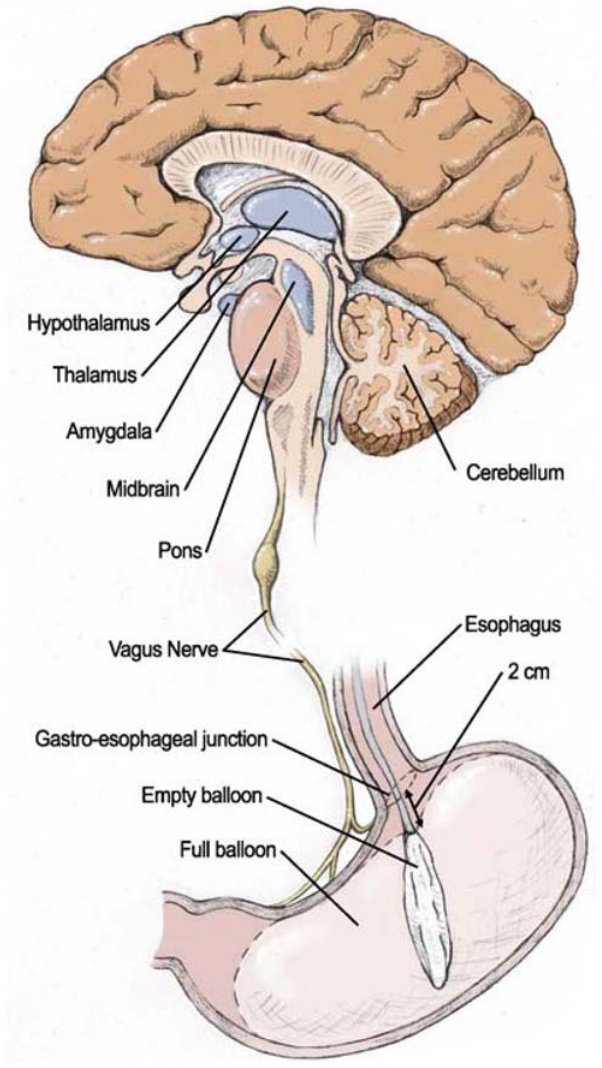
Figure 1. Gradual gastric distention (GD) paradigm. The deflated balloon was inserted orally and positioned in the stomach 2-cm above the gastro-esophageal junction. The solid and dashed lines depict the emptied (0 ml) and filled (500 ml for GD1 or 700 ml for GD2) balloon conditions. The balloon was filled and emptied with constant flow (5 ml/s) of tap water (warmed at 37 u C) in either 90s to 500 ml (GD1) or in 140 s to 700 ml (GD2). The vagus nerve transmits the signal of a full stomach to the solitary and parabrachial nuclei in the brain stem that project to dopaminergic and serotonergic nuclei in midbrain and pons. Other regions implicated in the control of food intake are additionally highlighted (hypothalamus, amygdala, and cerebellum).